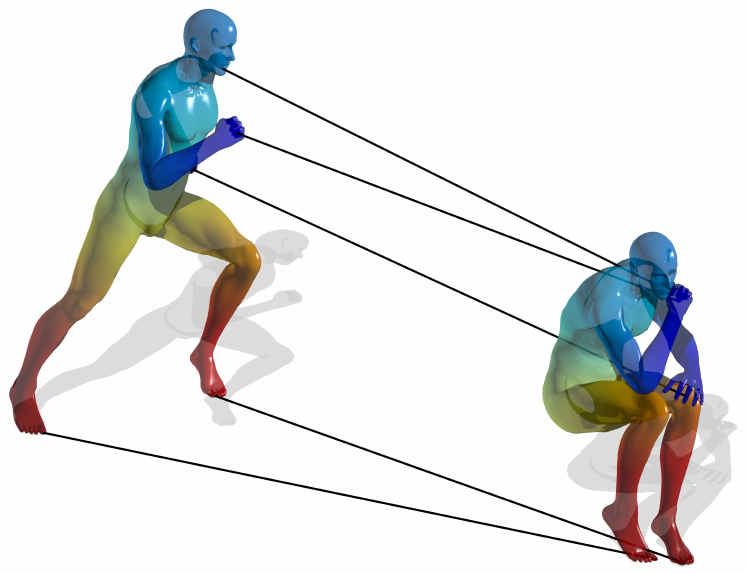
Figure 4. Feature point correspondence of two nearly isometric shapes of a